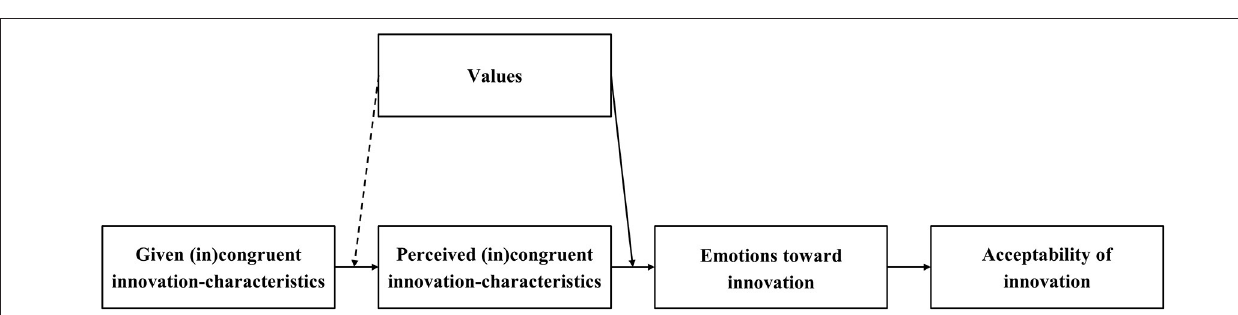
FIGURE 1 | The Value-Innovation-Congruence model of Emotional responses (VICE model).